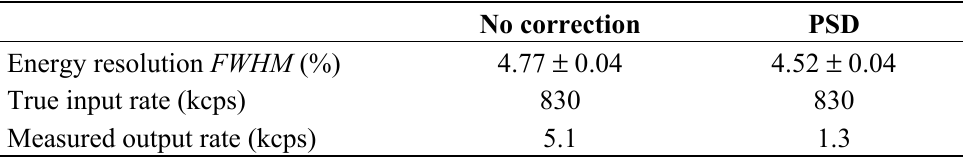
Table 1. Spectroscopic results at 22.1